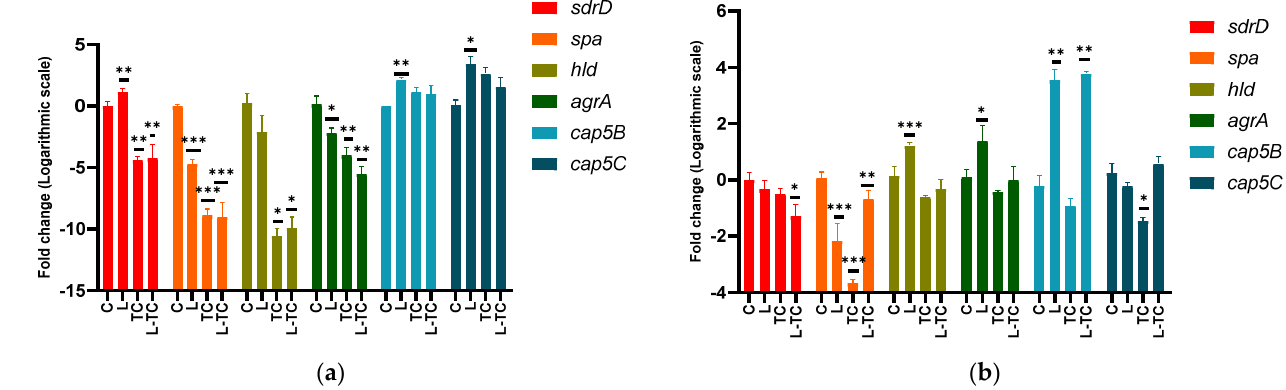
Figure 2. Effect of Linalool, ( − )- trans -caryophyllene and their combination on gene expression of sdrD, spa, hld, agrA, cap5B, cap5C in ST5-t311 isolate ( a ), and ATCC 25923 ( b ). The average of three measurements and the standard deviation are presented in each case. The effect of each concentration is compared with respect to control (one-way ANOVA, Dunnett’s post hoc test) * p < 0.05, ** p < 0.01, and *** p < 0.001 indicate significance. C—control; Lin—Linalool; TC—( − )- trans -caryophyllene. The three conditions tested in both isolates reduced the spa gene expression.